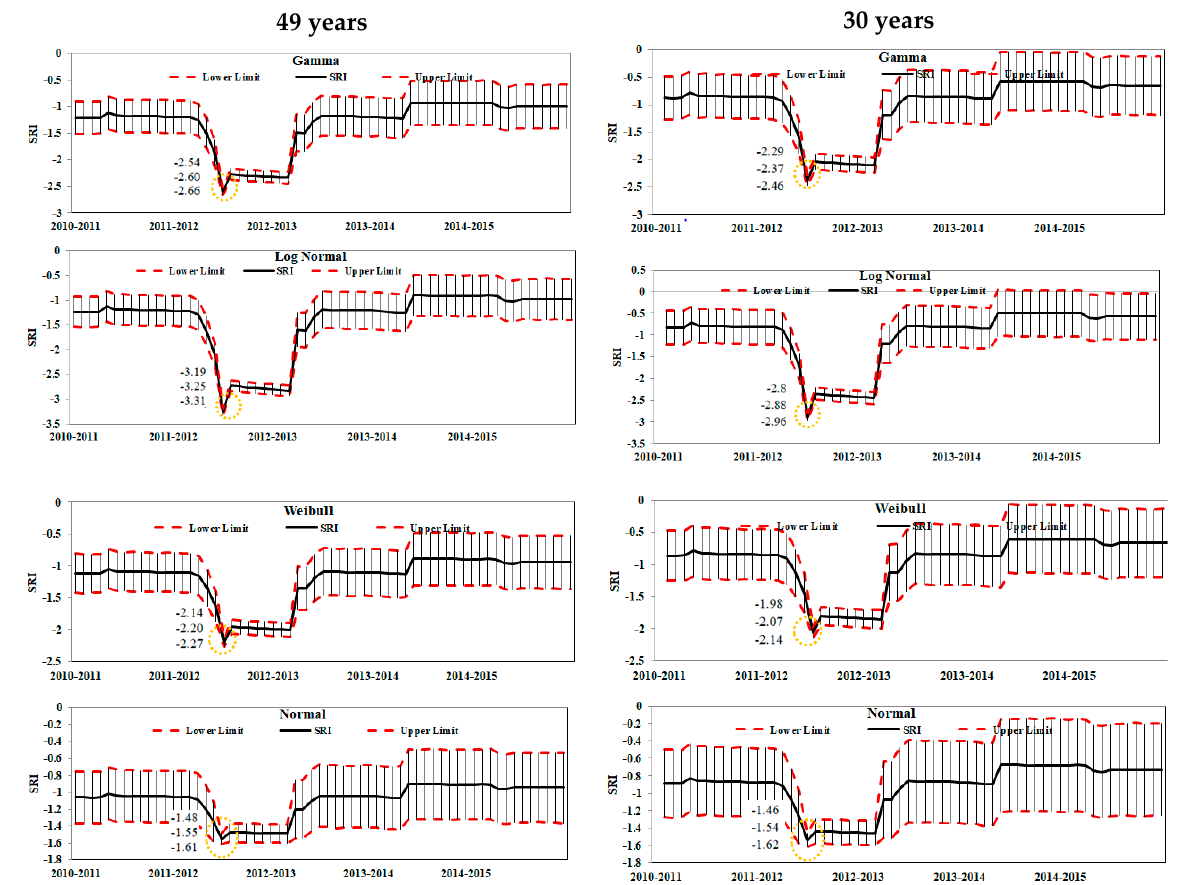
Figure 5. Time series 2010-11–2014-15 of SRI-48 and of the corresponding 95% confidence limits according to different underlying probability distributions (Gamma, Lognormal, Normal, and Weibull) (Aug 2011–12).